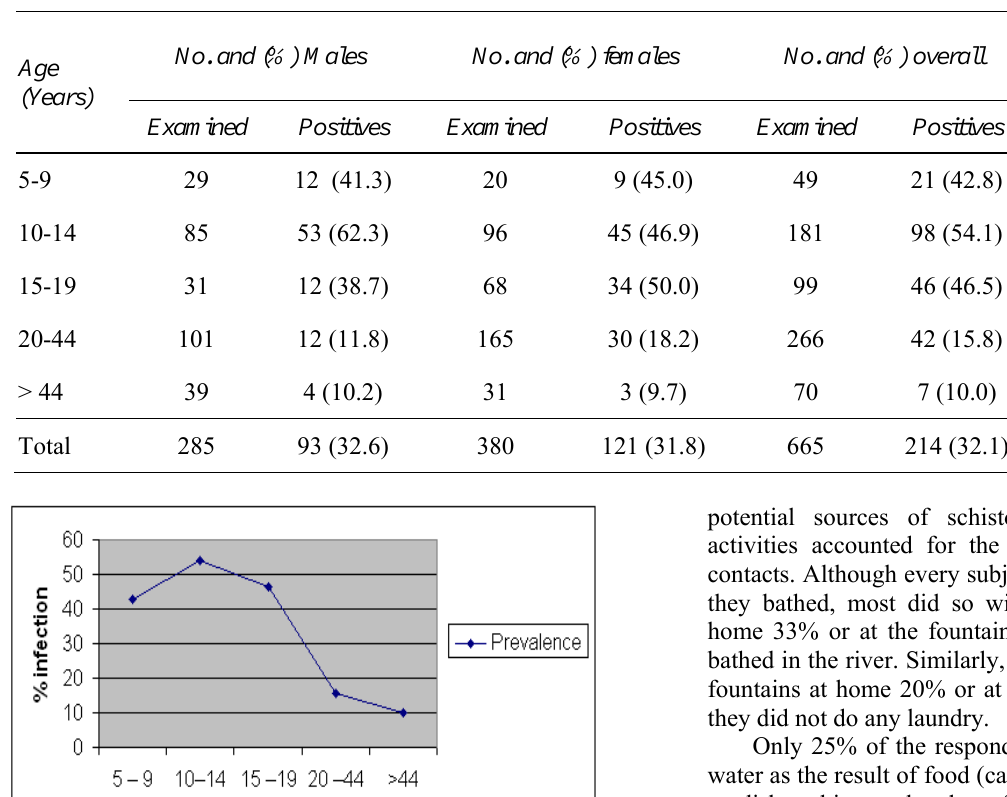
Table 2: Prevalence and intensity of S. haematobium infection